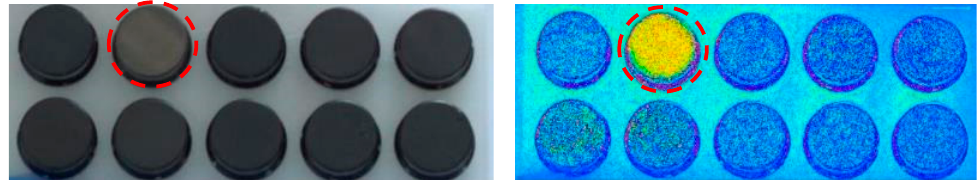
Figure 4. RGB image of coated parts ( left ) and hue image ( right ); the defective part (dotted circle) has a reduced coating thickness than the